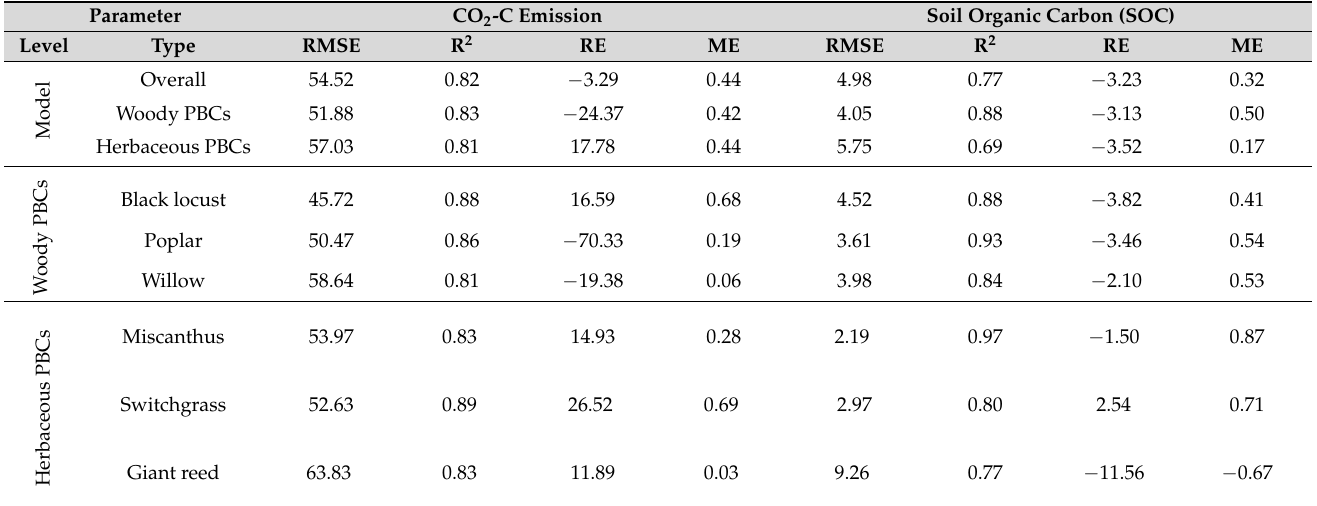
Table 3. Evaluation of ECOSSE performances in simulating (a) the CO 2 emission from the soil in the first 2 years within the reversion of the eleventh year of perennial biomass crop trial and (b) the soil organic carbon stock from the onset of PBCs cultivation in 2007 until the second year after the reversion (2020). Indicators are: Root mean square error (RMSE), regression coefficient (R 2 ), relative error (RE), and model efficiency